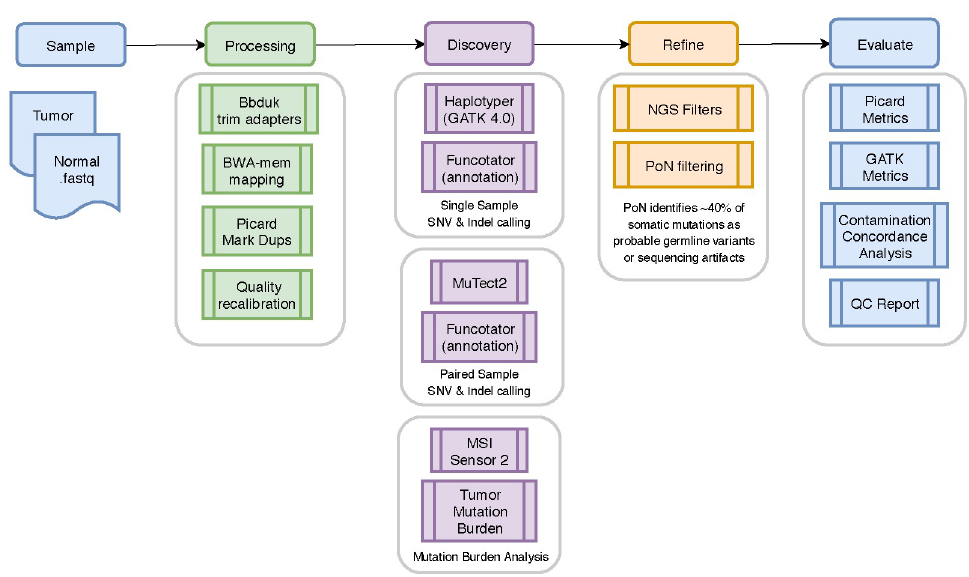
Fig 1. Flow diagram illustrating the bioinformatics pipeline used by M2Gen. Republished from M2Gen (https://www. m2gen.com/) under a CC BY license, with permission from Oliver A. Hampton, original copyright